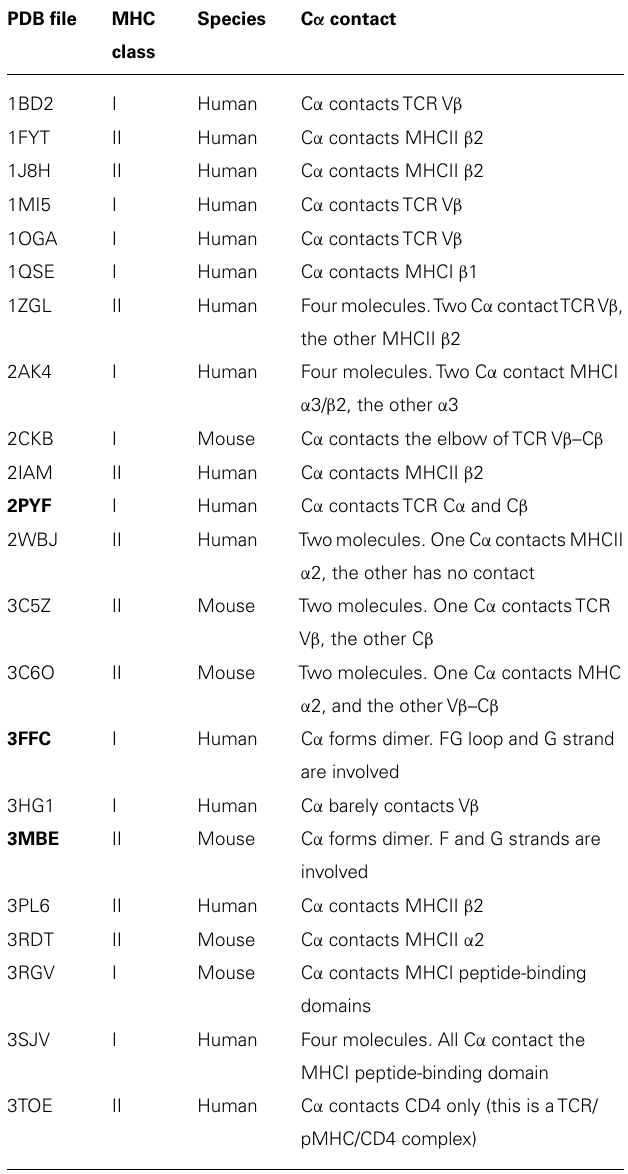
Table 1 | Molecular contacts among complexes in human and murine αβ TCR/pMHC